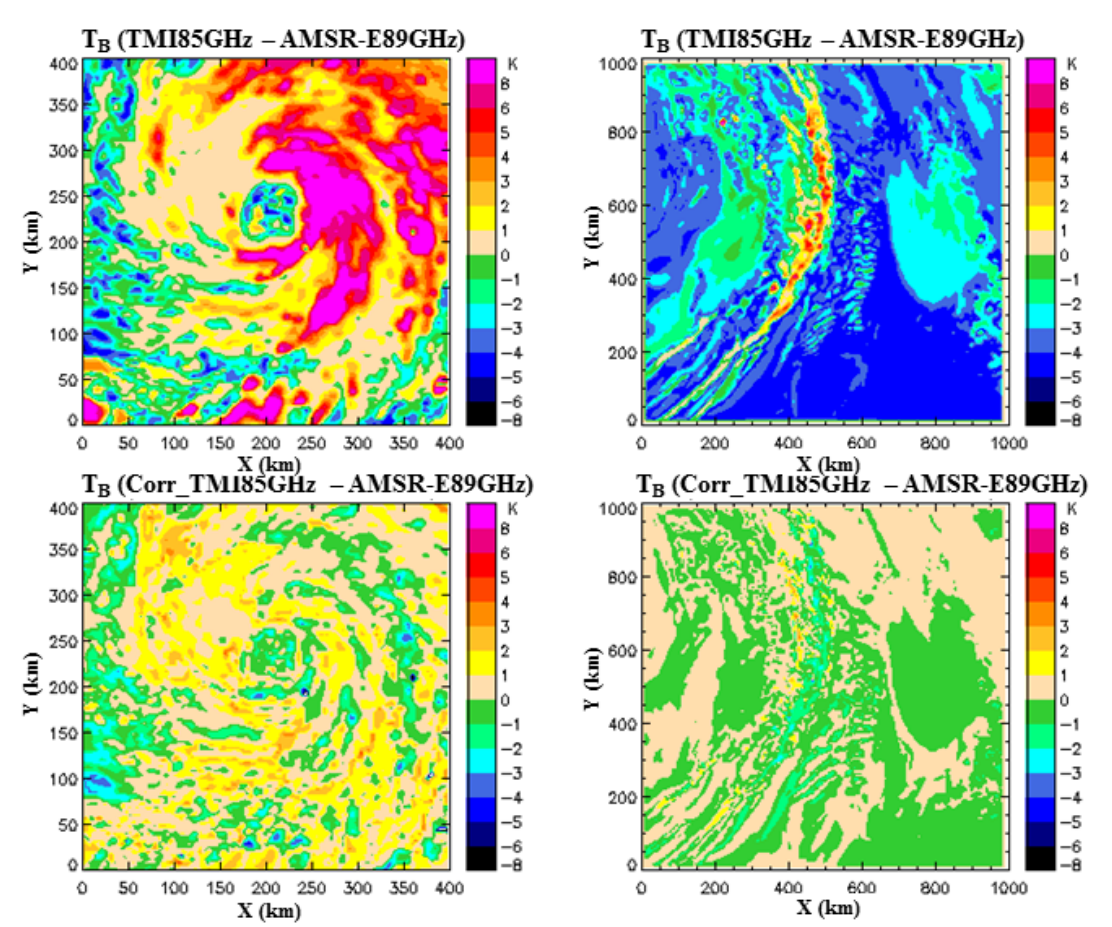
Figure 8. T difference between TMI 85-H and AMSR-E 89-H GHz before calibration B ( top panels ) and after calibrated TMI ( bottom panels ) for Hurricane Bonnie ( left panels ) and squall line ( right panels